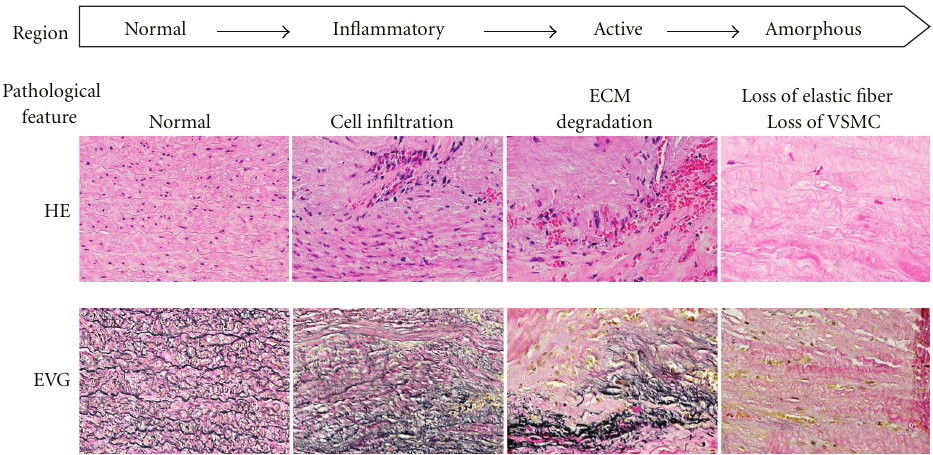
Figure 1: Heterogeneity of the histopathology of human abdominal aortic aneurysm (AAA). Regional heterogeneity within three distinct regions—inflammatory, active, and amorphous—is demonstrated. The order of these distinct regions may correspond to AAA progression from early to advanced phases. ECM: extracellular matrix; VSMC: vascular smooth muscle cell; HE: hematoxylin and eosin; EVG: elastica Van Gieson.